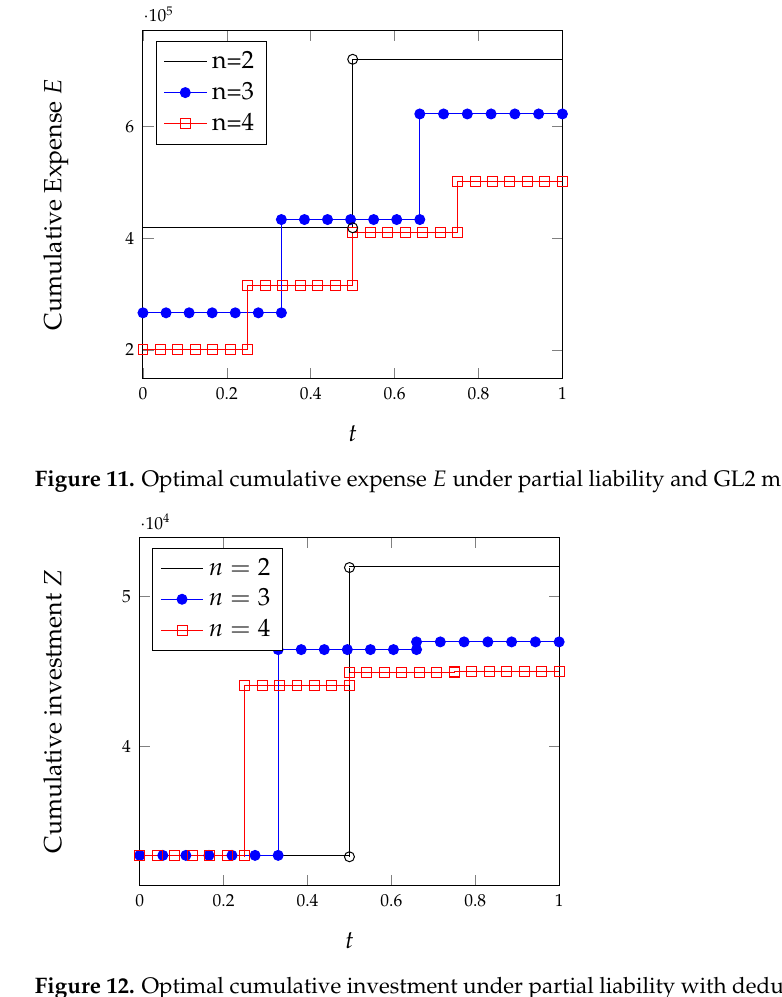
Figure 12. Optimal cumulative investment under partial liability with deductibles and GL2 model.